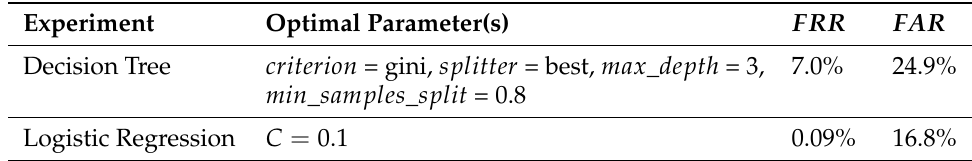
Table 5. Experimental results using supervised learning